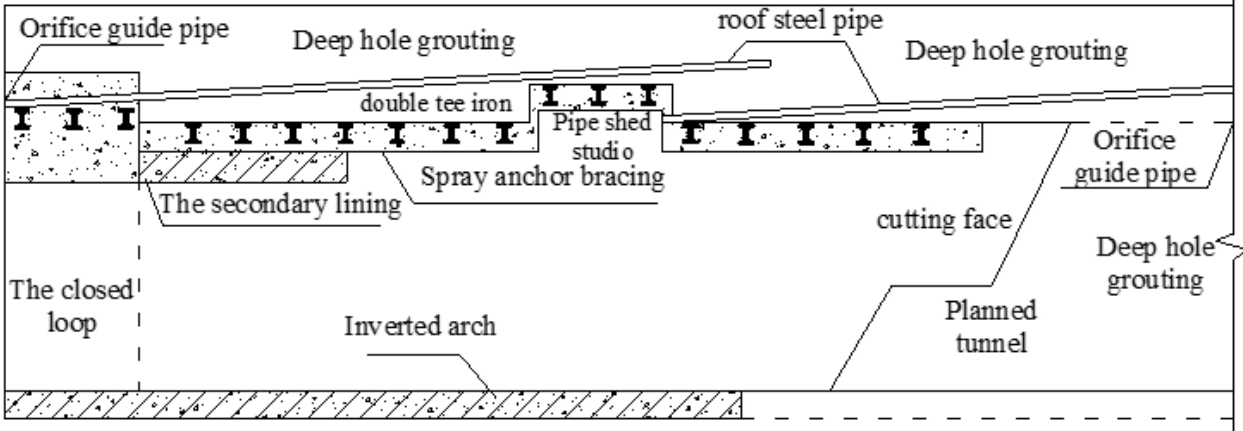
Figure 5. Diagram of composite pre-support with overrun pipe shed and deep hole grouting.